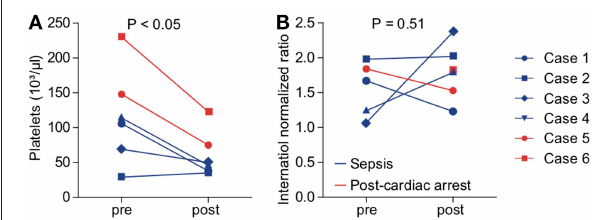
FIGURE 3 | Indicators for adverse effects of cytokine adsorption during ECMO therapy. Platelet count (A) and international normalized ratio (INR, B ) were determined before (pre) and after (post) onset of cytokine adsorption. Blue, septic shock; red, cardiac arrest. Blue circle, case 1; blue square, case 2; blue diamond, case 3; blue triangle, case 4; red circle, case 5; red square, case